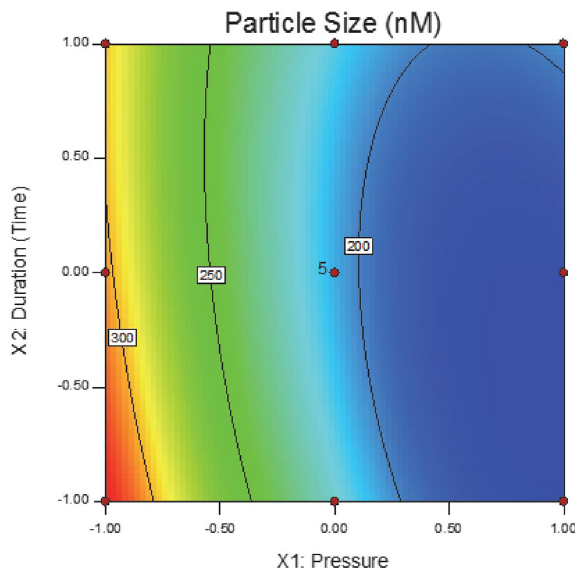
Figure 2. Contour plot indicating that the homogenization pressure (X 1 ) is the most influential factor compared to the duration of ho- mogenization (X 2 ) on average particle